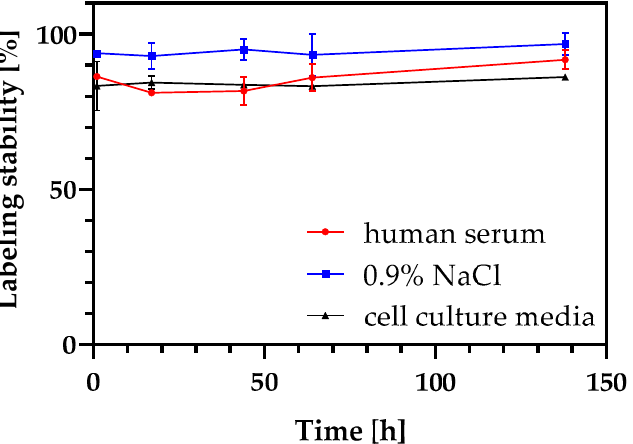
Figure 1. Radiolabeling of the nanodiamonds. 89 Zr- and 68 Ga-labeling diagram of bound activity in terms of time, followed for 4.5 h ( 68 Ga) and 24 h ( 89 Zr), respectively ( a ). For zirconium-89 already after 2 h of incubation (97 ± 3)% of the radioactivity was bound to the nanodiamonds ( a ) as observed by thin layer autoradiography. In the exemplary TLC the relative proportion of bound and free zirconium-89 or gallium-68 is given in percent ( b ).